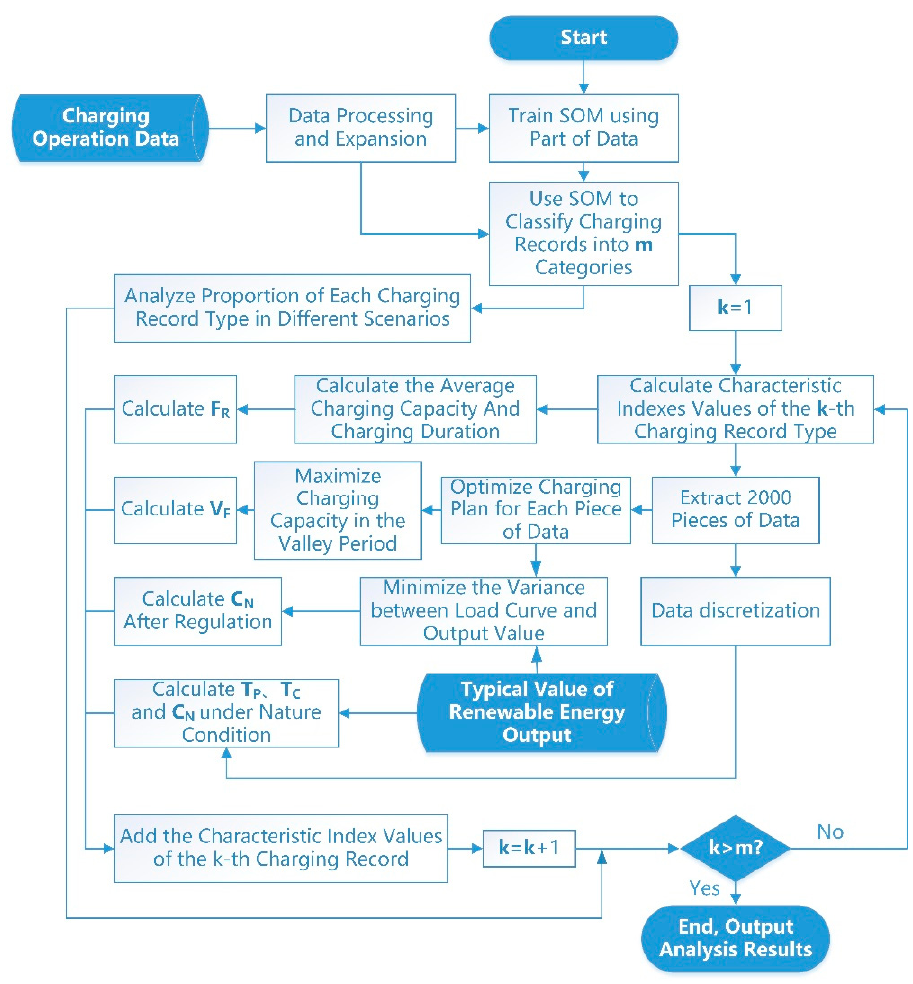
Figure 3. Load characteristic analysis flow.